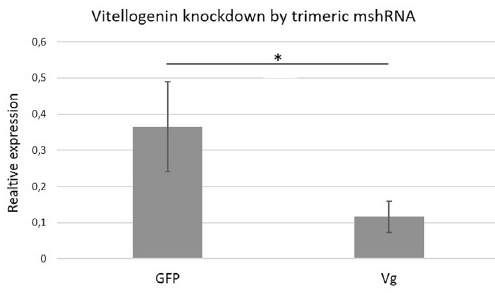
Figure 3 - Gene silencing mediated by trivalent multimeric shRNA de- signed by SSD. GFP group was injected with 500 ng of mshRNAs against GFP gene (negative control); Vg group was injected with 500 ng of mshRNAs against Apis mellifera vitellogenin. All experiments were per- formed in 6-8 biological replicates, each one composed of technical tripli- cates. Statistical difference was evaluated by ANOVA, with Student T test as post-hoc (* means p < 0.05